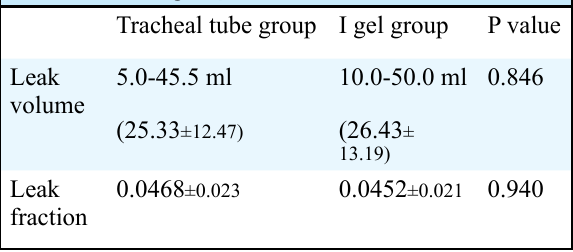
Table 3. Comparison of leak volume and leak fraction in two